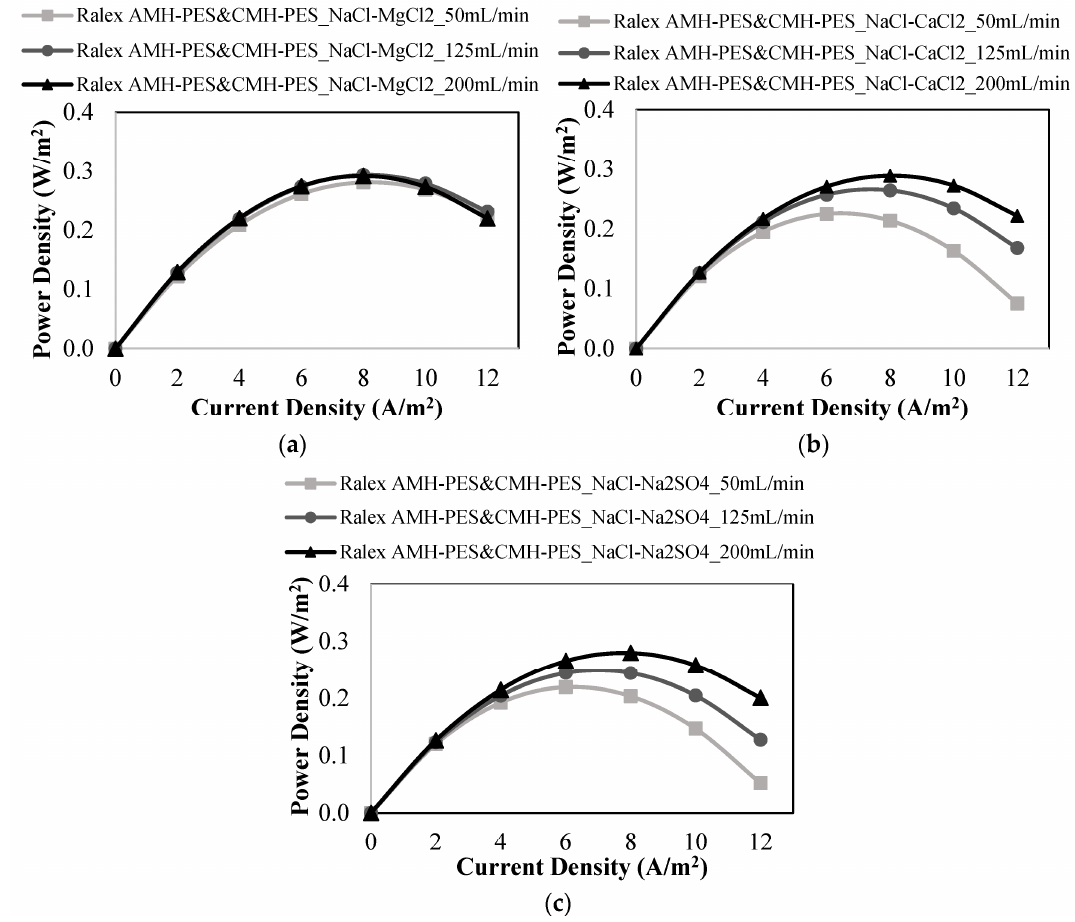
Figure 5. Power density vs. current density plots at different feed flow rates for the studies performed with ( a ) a mixture of NaCl and MgCl 2 , ( b ) a mixture of NaCl and CaCl 2 , ( c ) a mixture of NaCl and Na 2 SO 4 using Ralex AMH-PES & CMH-PES membranes.